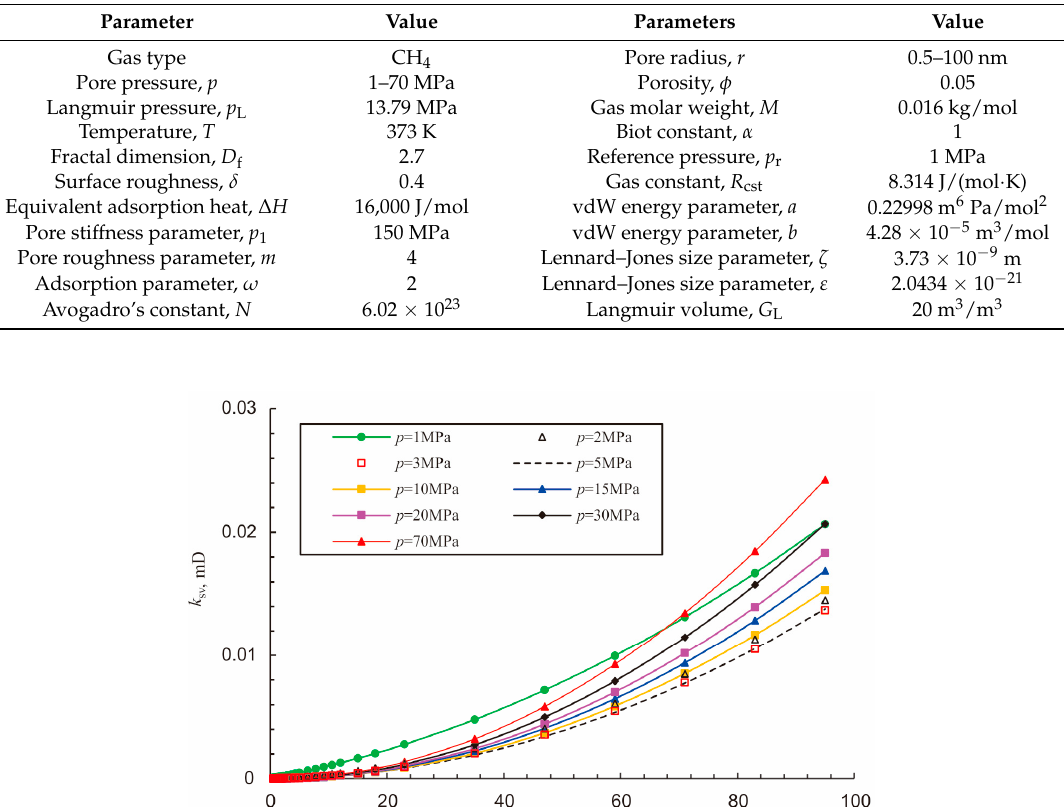
Figure 9. Equivalent permeability of slip viscous flow in different conditions.